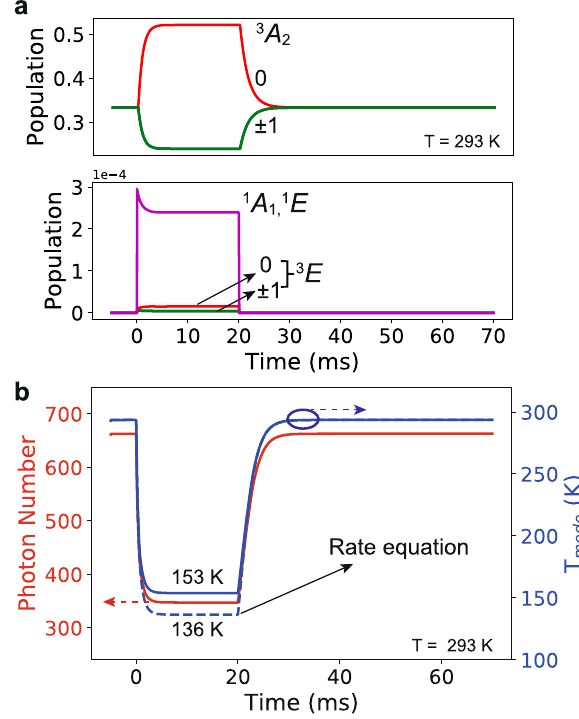
Fig. 2 Cooling dynamics of an NV spin ensemble and a microwave resonator mode. a Population of the spin levels of the electronic ground state (the upper panel), and the population of those of the electronic excited state and the representative singlet excited state (lower panel). b Intra-resonator photon number (red solid line, left axis) and the effective mode temperature (right axis) calculated with the multi-level JC model (blue solid line) and the rate equations (blue dashed line). Here, the diamond is illuminated by a 532 nm laser with 2 W power and 20 ms duration, and there is no microwave driving fi eld. Other parameters are speci fi ed in the Supplementary Table